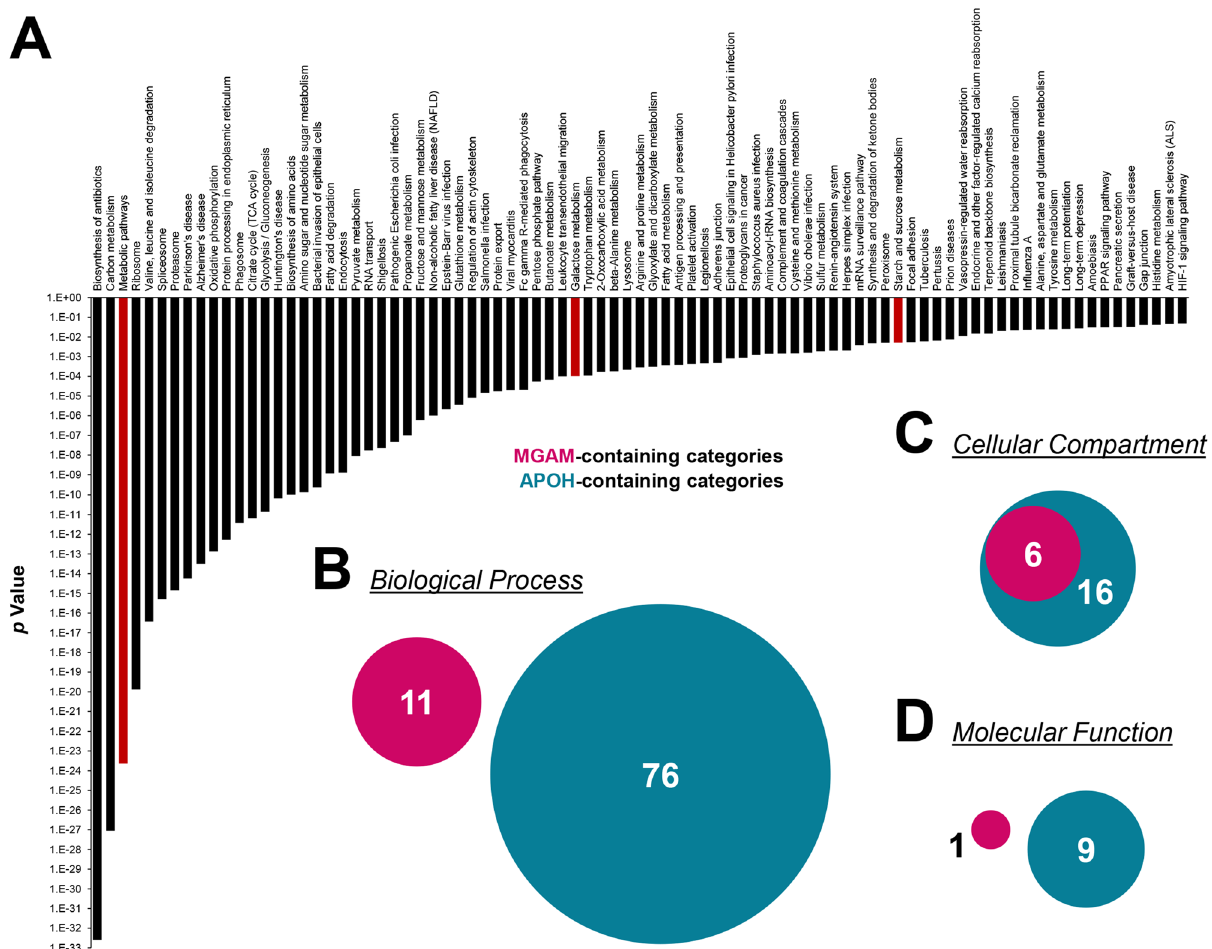
Figure 5. MGAM and APOH characterization in human colon mucosal proteomes. ( A ) Significant biological pathways enriched among 3,266 proteins identified by TMT are represented as bar graphs ( p < 0.05) with the MGAM-containing categories highlighted in red. Venn diagrams showing numbers of MGAM-and APOH- containing categories classified by cellular compartment ( B ), molecular function ( C ), and biological process ( D ) based on functional annotation with gene ontology (GO)